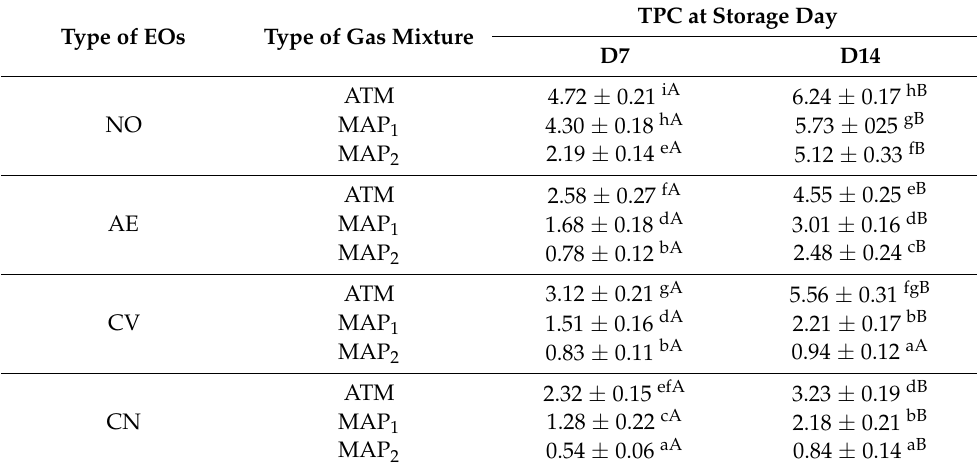
Table 1. The total plate count (log (cfu/g)) of GF cake rich (mean ± SD; n =